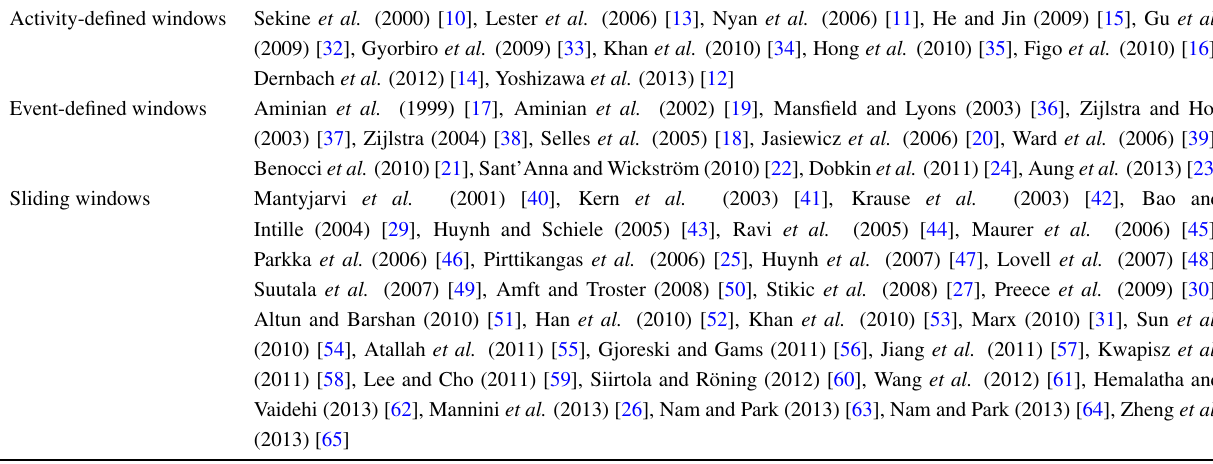
Table 1. Principal segmentation